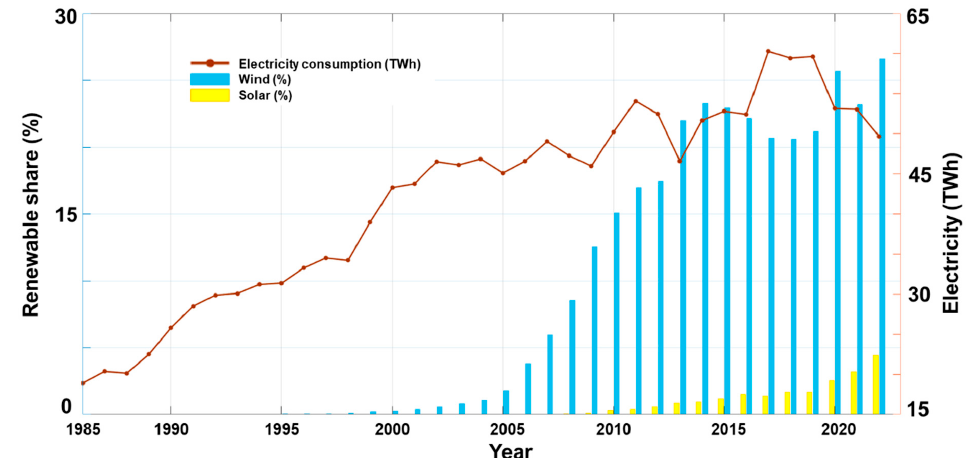
Figure 2. Portugal’s electricity balance (1985–2020) distributed between electricity consumption and electricity generation from wind and solar sources. Information processed from [29].